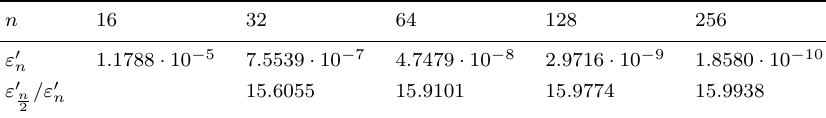
Table 1. Numerical results for ε (cid:48) n = S (cid:48) ( − 1 . 1) − y (cid:48) ( − 1 . 1). n 16 32 64 128 256 ε (cid:48)